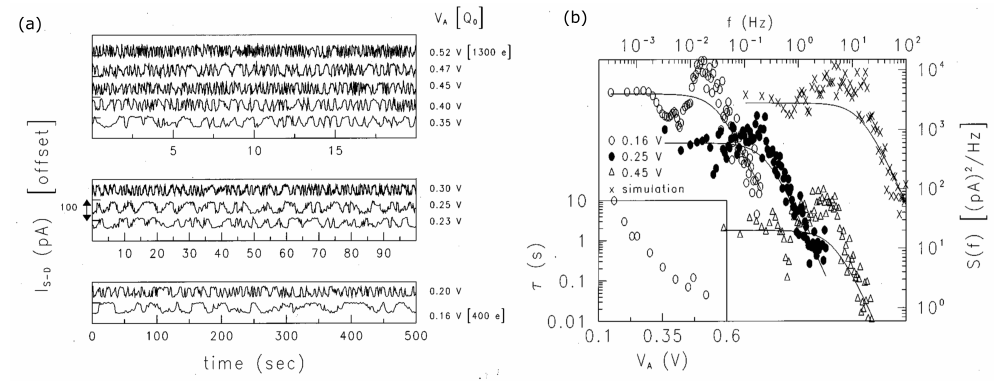
Figure 4. ( a ) current fluctuations as a function of time and gate voltage in an Al/AlO x /Al device. The data are made up of steps or collections of steps from a single dominant defect. The frequency of steps increases with gate voltage while the amplitude and duty cycle remain the same; ( b ) power spectral density of the noise in ( a ) at selected gate voltages. The data show a Lorentzian, flat at low frequencies and 1/ f 2 at high frequencies, dependence with different knee frequencies. Data were obtained at a temperature of about 15 mK. Inset shows the characteristic time extracted from the Lorentzian fits showing a roughly exponential dependence on gate voltage. Reproduced with permission from reference [40], Copyright 1997, American Physical Society.